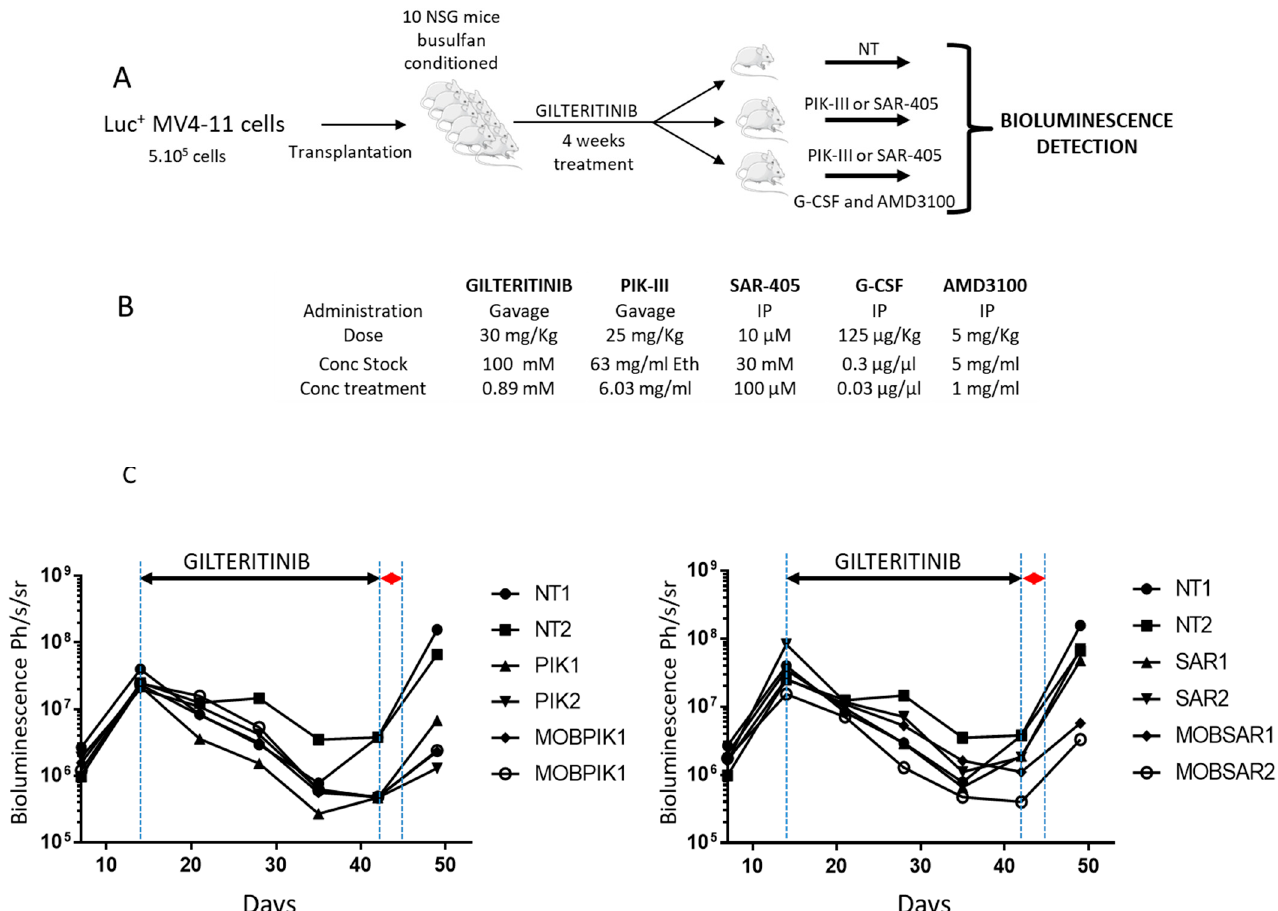
Figure 5. Inhibition of autophagy by Vps34 inhibitors and mobilization decrease relapse rate in vivo. ( A ) NSG mice were xenografted by IV injection of MV4-11 cells (5 × 10 5 ). After two weeks, mice were treated by daily oral gavage of gilteritinib (30 mg/kg). After 4 weeks of treatment, mice were randomized and treated for two days as follows ( B ) NT (not treated), SAR (SAR-405 10 µ M IP), MSAR (SAR-405 10 µM, G-CSF 125 µg/kg, AMD3100 5 mg/mL IP), PIK (PIK 25 mg/kg gavage) and MPIK (PIK 25 mg/kg gavage, G-CSF 125 µg/kg IP, AMD3100 5 mg/mL IP). ( C ) Bioluminescence was performed every 7 days (d 7 ,d 14 ,d 21 , d 28 , d 35 , d 42 and d 49 ).